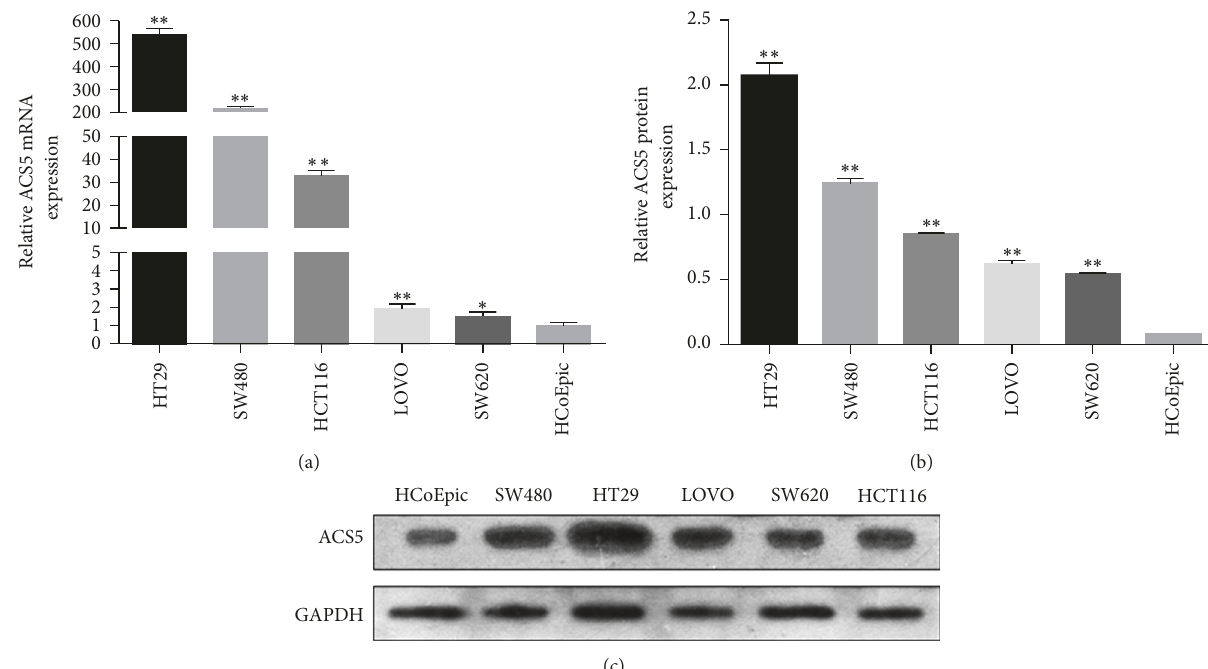
Figure 1: Expression of ACS5 in CRC cell lines. The ACS5 mRNA and protein levels were significantly upregulated in five CRC cells compared with the normal cell line (HCoEpiC). ∗∗ 𝑃 < 0.01 , ∗ 𝑃 < 0.05 versus HCoEpiC.